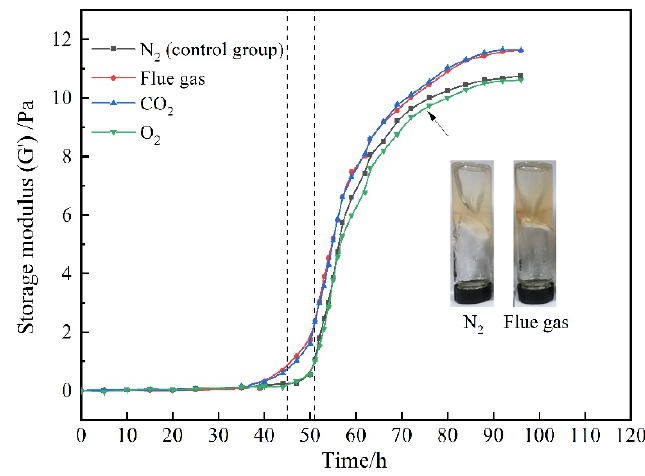
Figure 2. The gelation performance of resorcinol/HMTA-based polymer gel. ( a ) Effect of the concentrations of resorcinol and HMTA on the gelation time; ( b ) relationship between the storage modulus (G ′ ) of gels and the aging time as well as the mass ratio of resorcinol to HMTA; ( c ) effect of the concentrations of acetic acid on the gelation time.